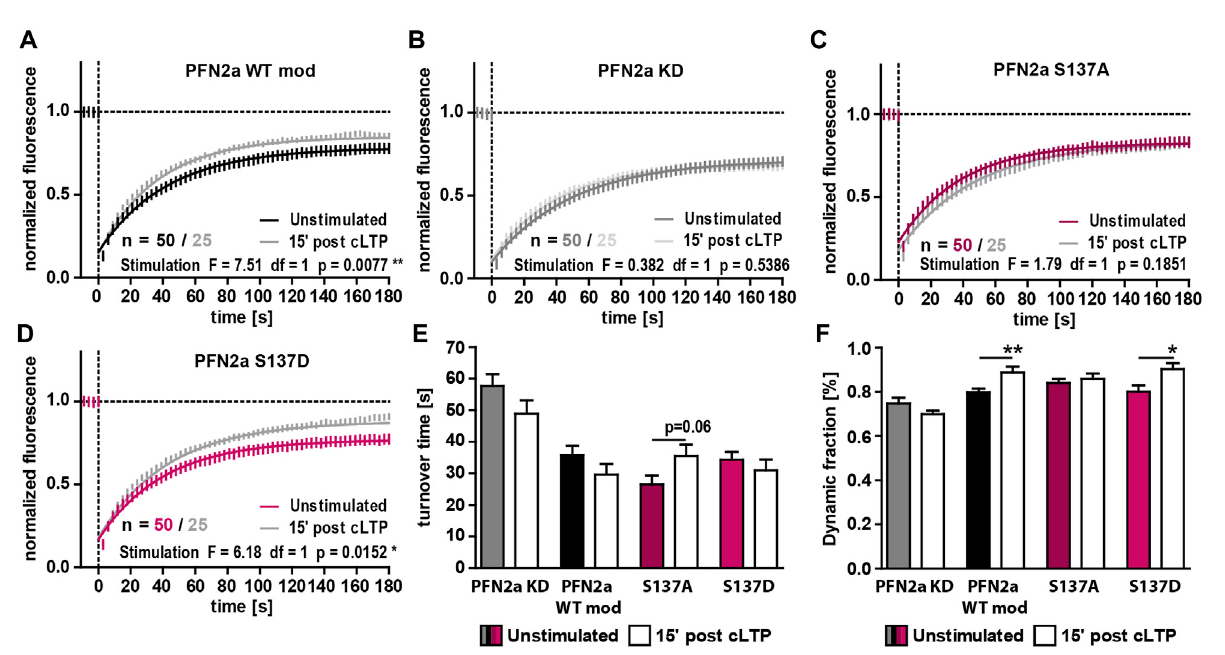
FIGURE 3 PFN2a phosphorylation at S137 mediates activity-dependent spine actin dynamics. (A – D) Fluorescence Recovery After Photobleaching (FRAP) experiments of EGFP-ß-actin analyzing actin dynamics 15 ′ post NMDAR-dependent cLTP induction in hippocampal neurons after 23 days in culture. Depicted are therecovery curves over atime course of180s after thebleaching pulse of dendritic spines from hippocampalneuronswhere endogenous PFN2a was knocked down and replaced with (A) WT PFN2a (PFN2a WT mod), (B) mApple (PFN2a KD), (C) PFN2a S137A or (D) PFN2a S137D. n = 50 (Unstimulated),25(postcLTP)dendriteseach.N=3experiments. (E) Quanti fi cationoftheturnovertime. (F) Quanti fi cationoftheamountof fl uorescence which recovered in the time period of 180s after the photobleach - the dynamic fraction of